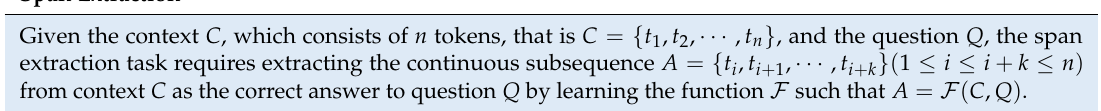
Table 5. Definition of span